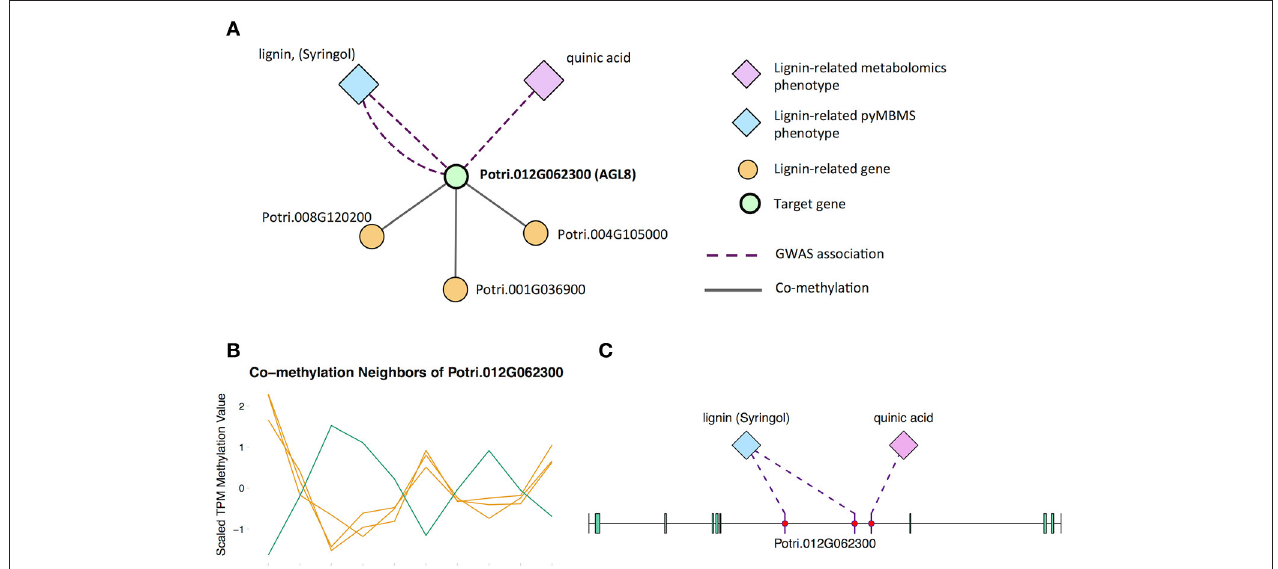
FIGURE 3 | (A) Lines of evidence for Potri.012G062300 (homolog of Arabidopsis AGL8). (B) Co-methylation of Potri.012G062300 with three lignin-related genes ( Table 3 ) The green line represents potential target Potri.012G062300 and yellow lines represent lignin-related genes. (C) GWAS associations of Potri.012G062300 with a lignin-related metabolite and a lignin-related pyMBMS peak ( Table 1 ).